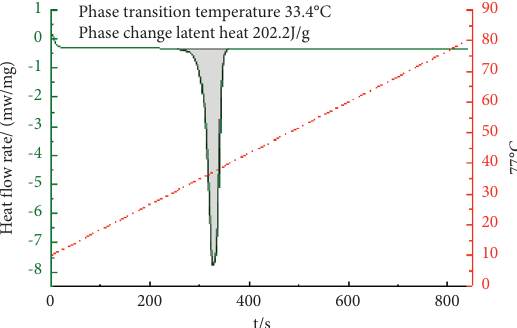
Figure 4: TD: MA is the DSC curve of TD-MA at 6.8:3.2. Phase transition temperature 33.1°C Phase change latent heat 208.3J/g